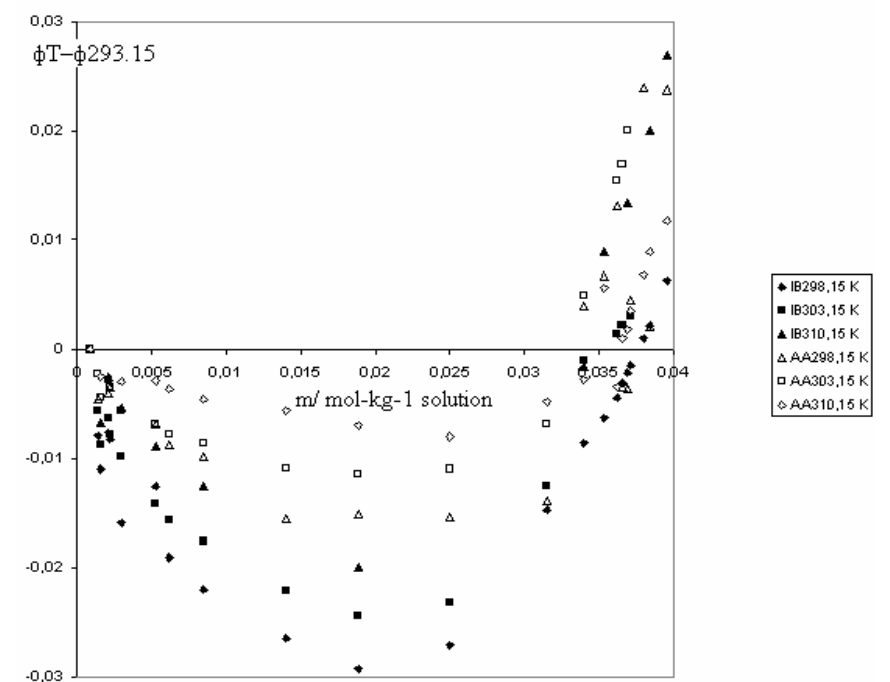
Figure 5. Dependences of a γ / γ various